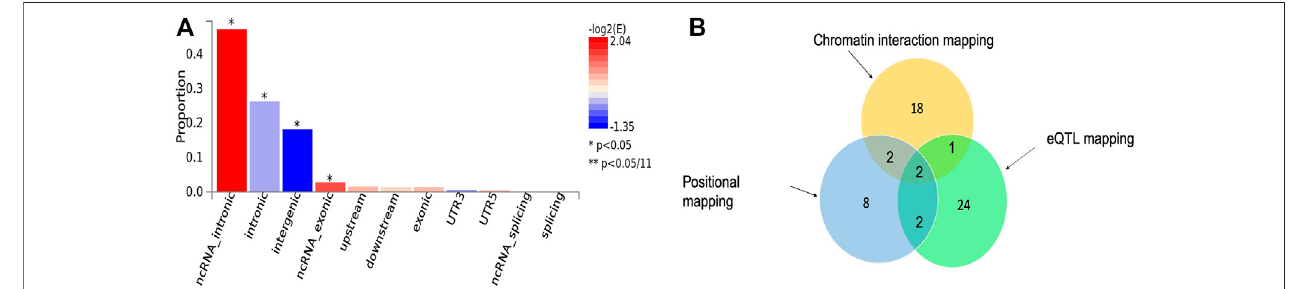
FIGURE 1 | (A) Proportion of malaria resistance GWAS SNPs in different genomic annotation categories. (B) The number of genes identi fi ed by each of the three functional mapping strategies including positional mapping, eQTL, and chromatin interactions. The intersection sections of the circles depict the number overlapped genes between the respective mapping